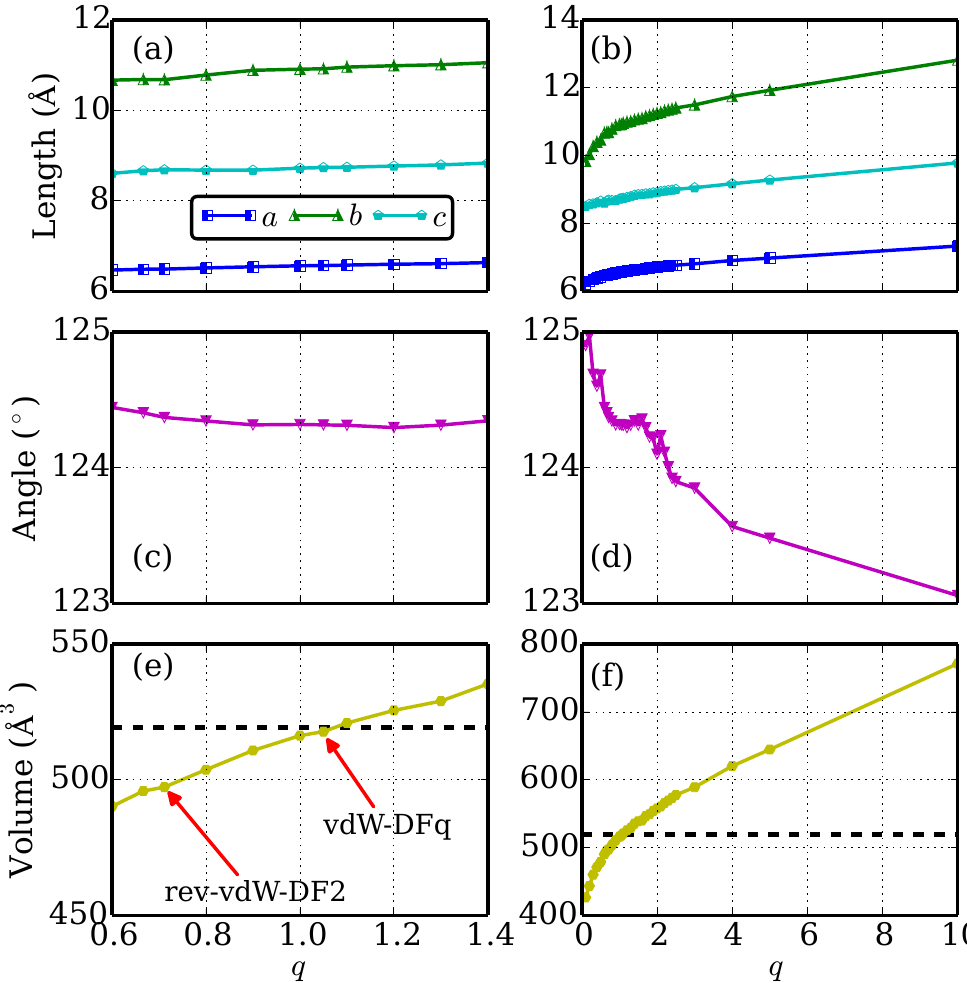
Figure 4. Geometry of β -HMX. The lattice constants a , b , c ( a , b ), lattice angle β ( c , d ), and volume of the unit cell V ( e , f ) predicted from the proposed vdW-DFq method as a function of the one-parameter q in a small range around 1.0 ( left ) and large range from 0 to 10 ( right ). The B86q and B86R denotes the case of q = 1.05 and 0.7114 respectively. The dashed line is the experimental